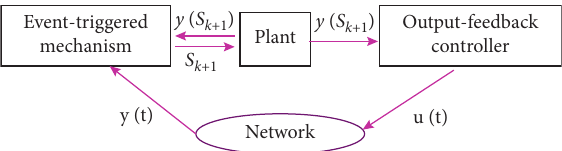
Figure 1: Diagram of the uncertain closed-loop